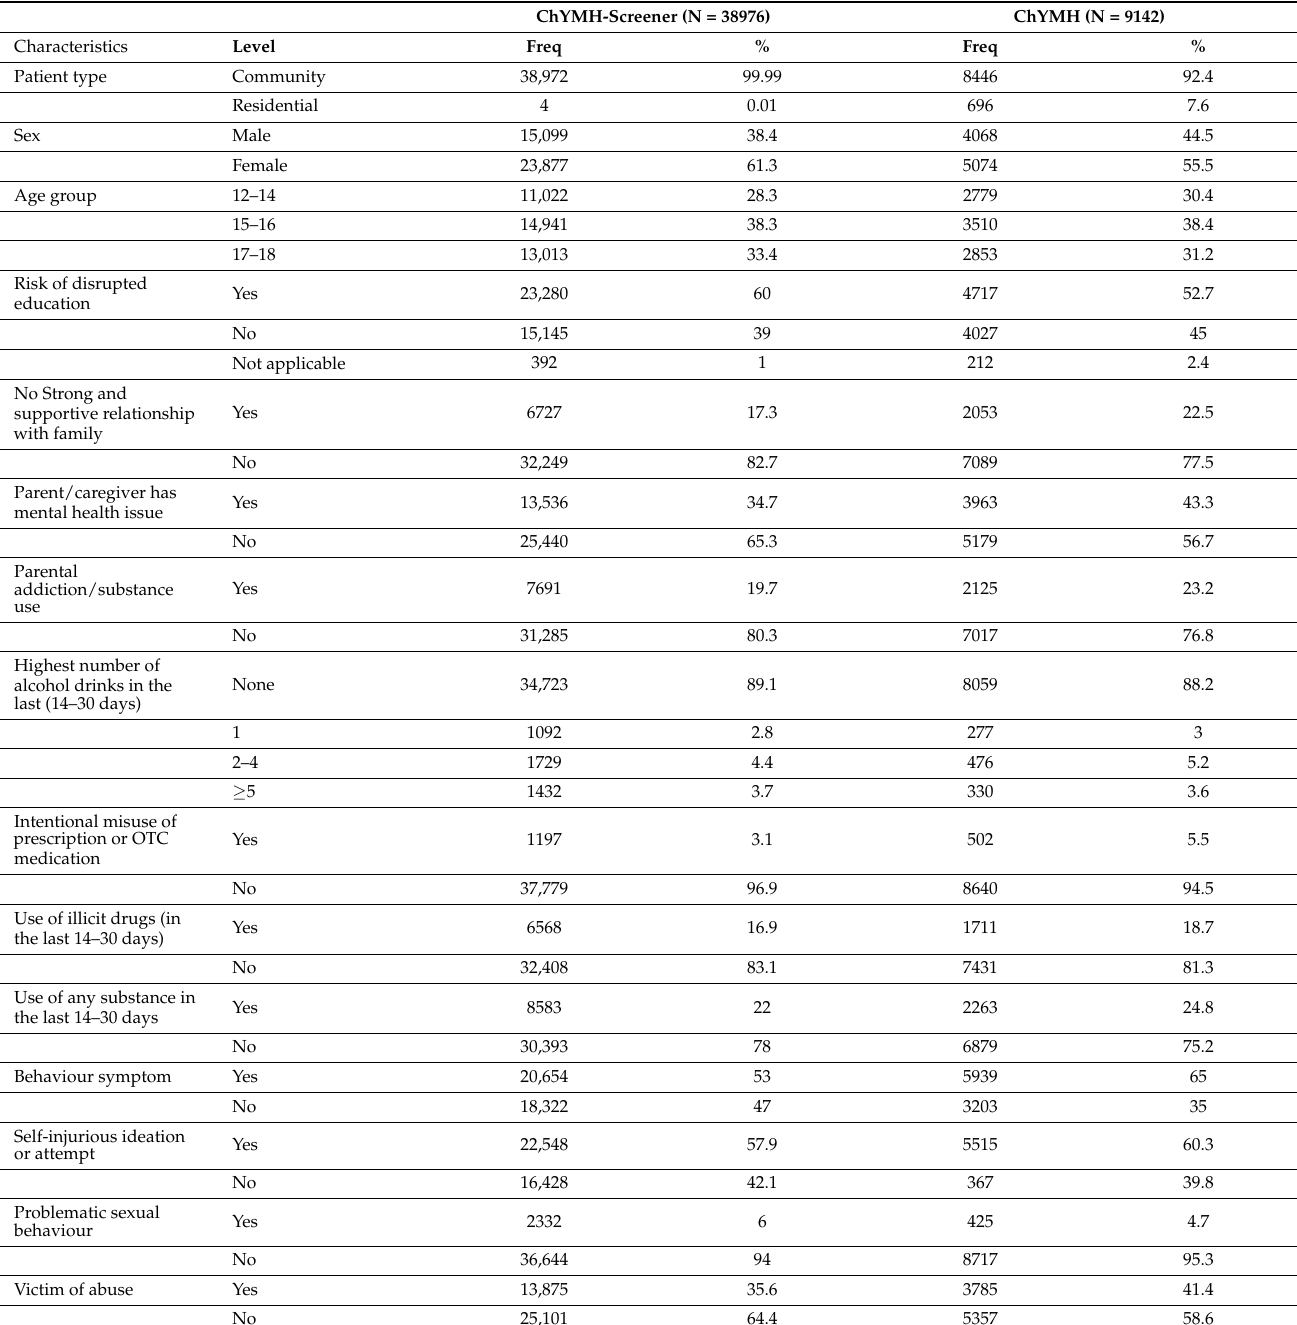
Table A1. Characteristics of ChYMH and ChYMH-S